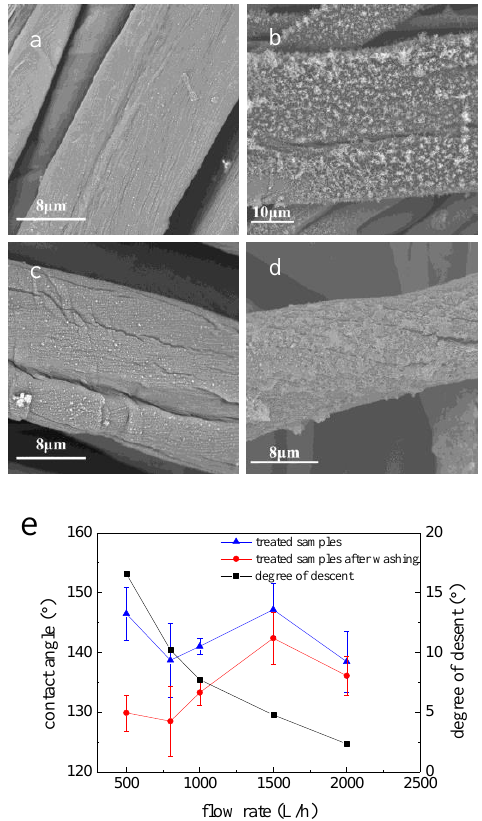
Figure 5. The effect of ionization flow rate on SEM images and CA values of N 2 plasma-treated plain cotton fabric.